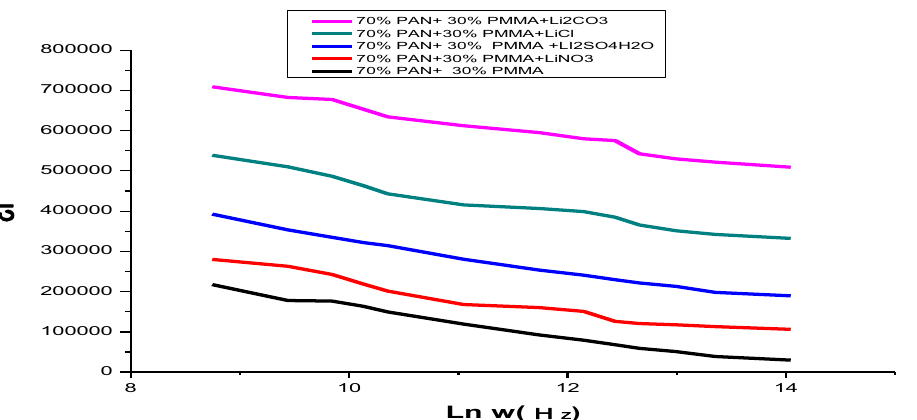
Figure 2c: The real dielectric constant as function of ln (ω) of undoped (72%PAN +30%PMMA) and doped with 20% (LiNO